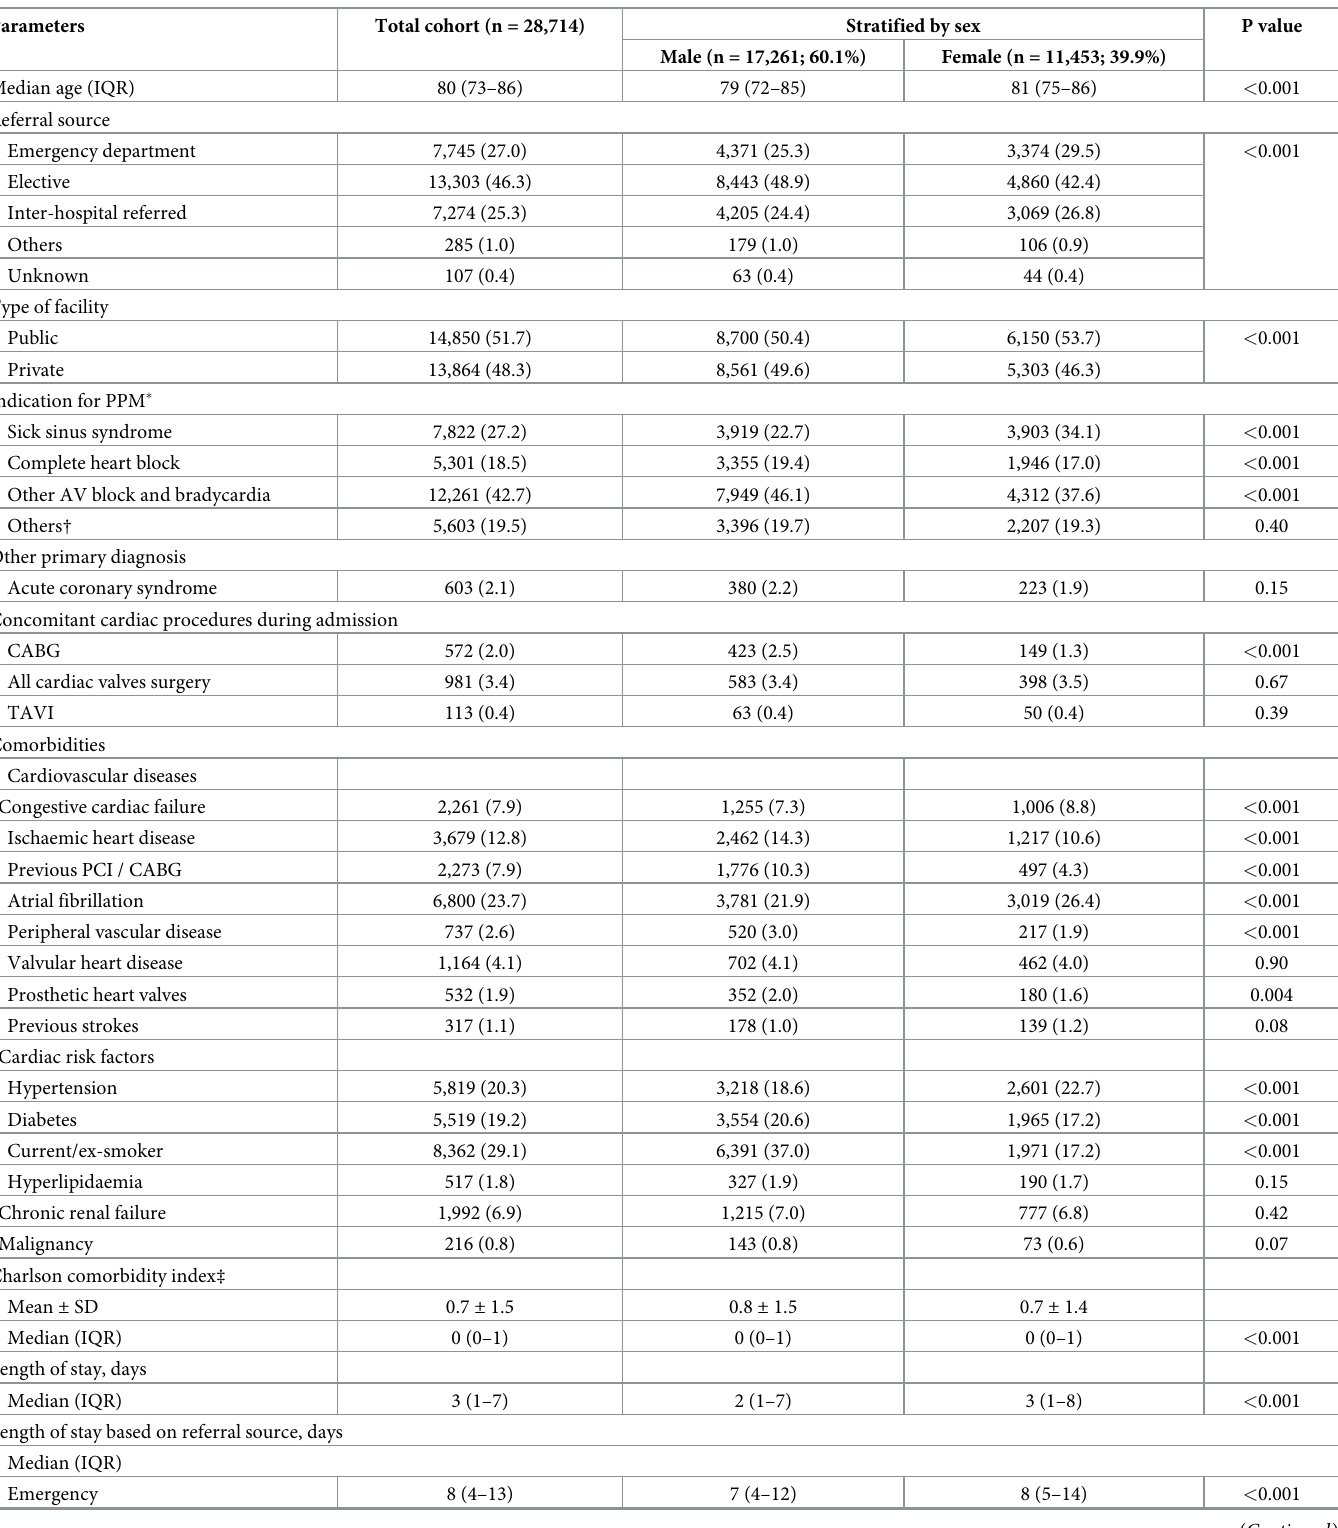
Table 1. Baseline